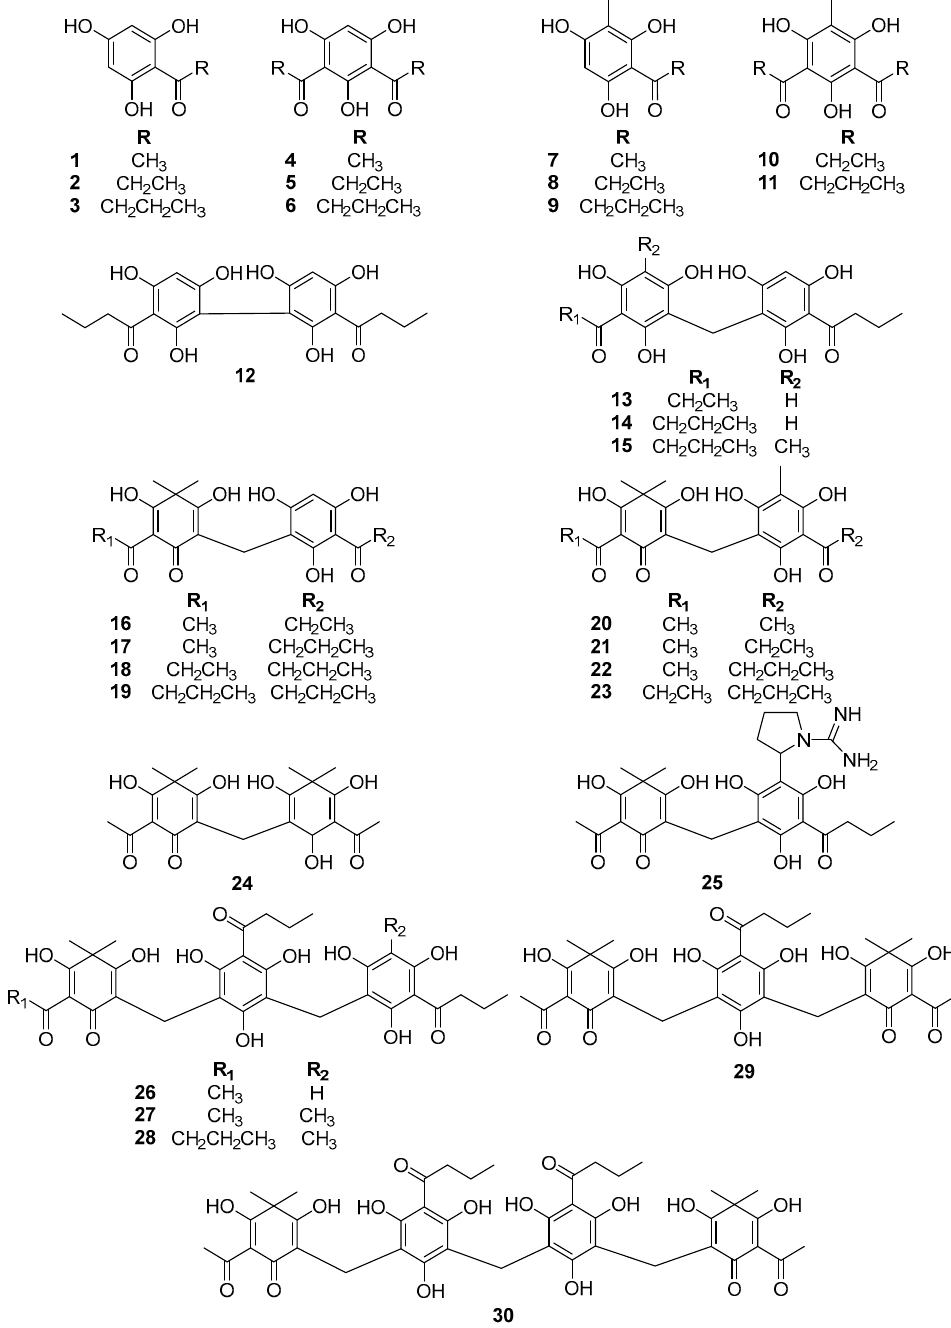
Figure 1. Chemical structures of phloroglucinols from D. crassirhizoma ( 1 – 30 ).